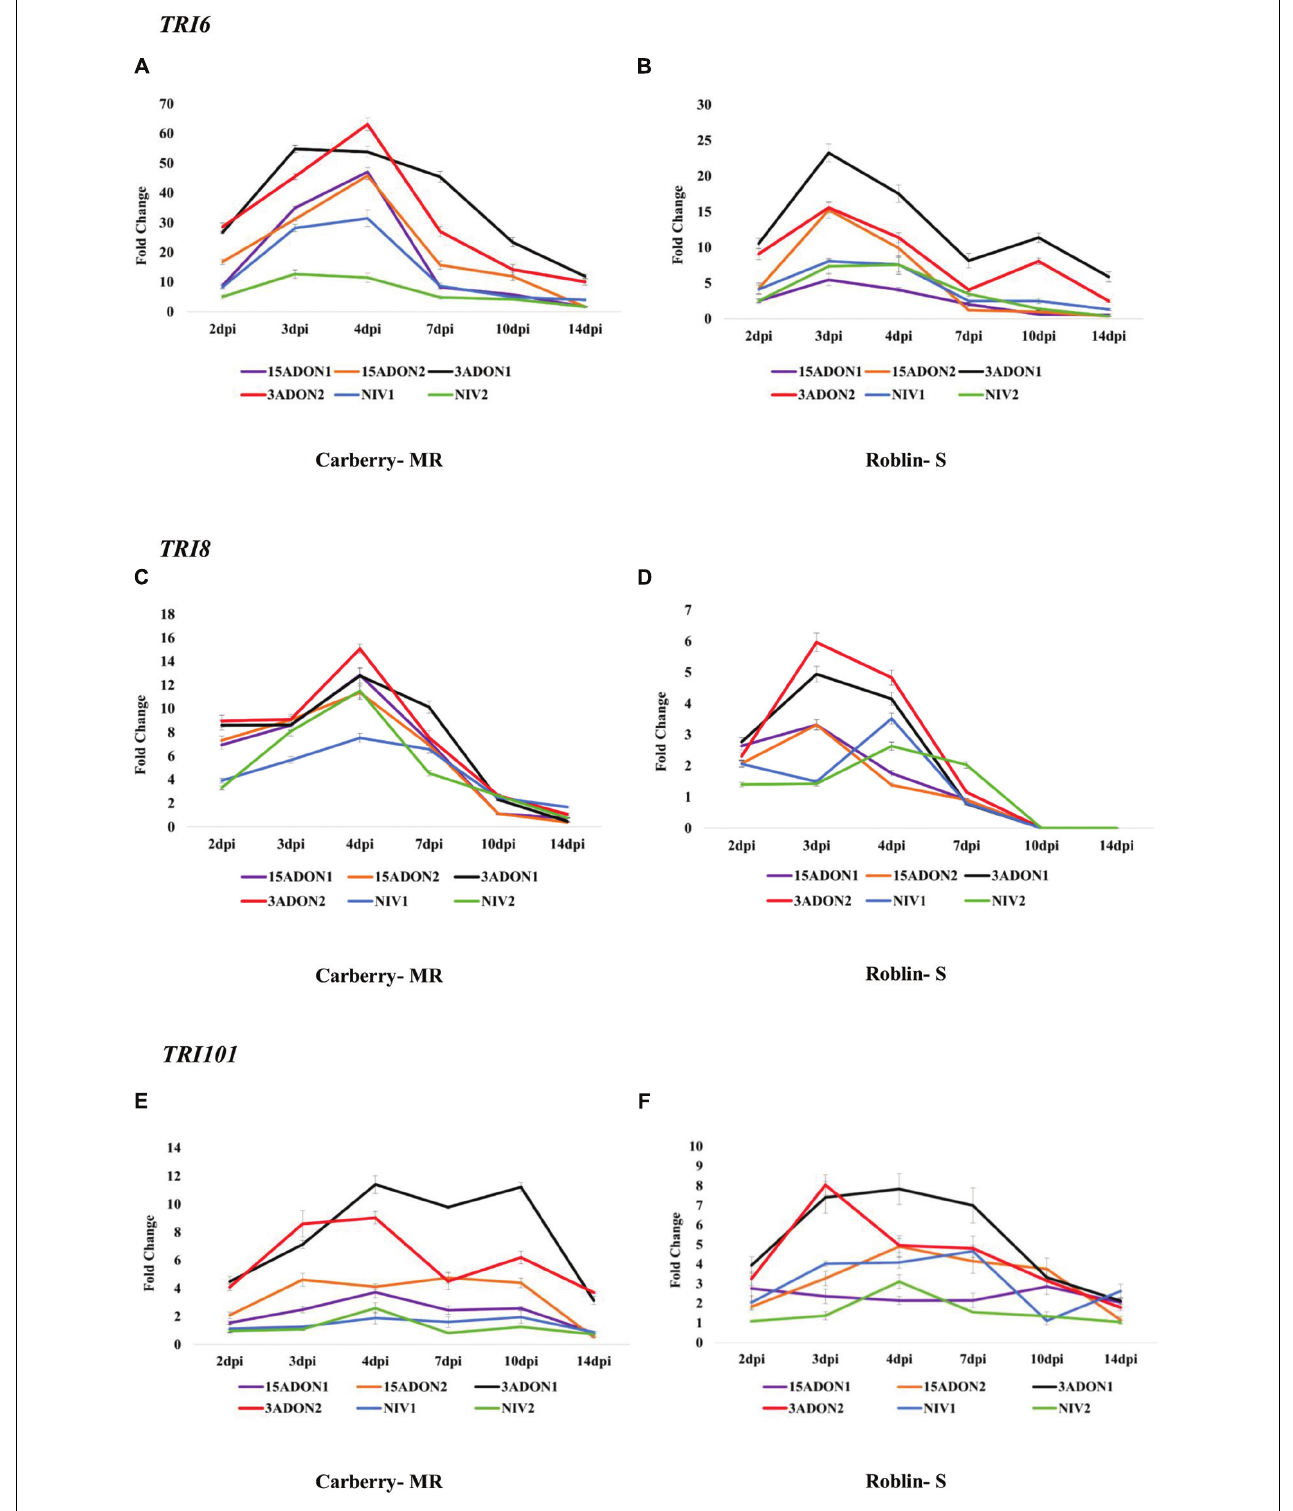
FIGURE 2 | Fold change in transcript levels of transcription factor TRI6 gene in cultivar Carberry (A) and cultivar Roblin (B), trichothecene 3- O -esterase ( TRI8 ) gene in cultivar Carberry (C) and cultivar Roblin (D) and trichothecene 3- O -acetyltransferase ( TRI101 ) gene in cultivar Carberry (E) and cultivar Roblin